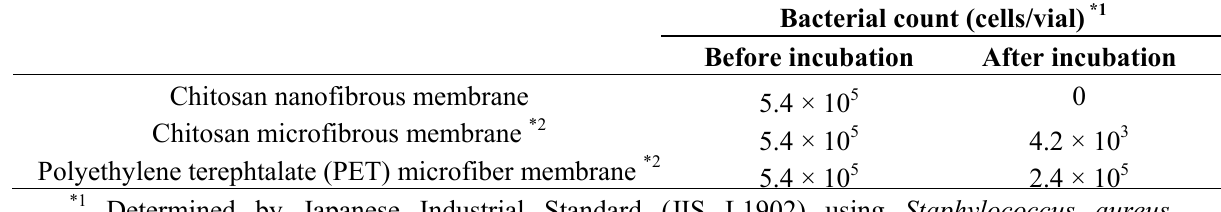
Table 3. Antimicrobial effect of fibrous membranes (Adapted from